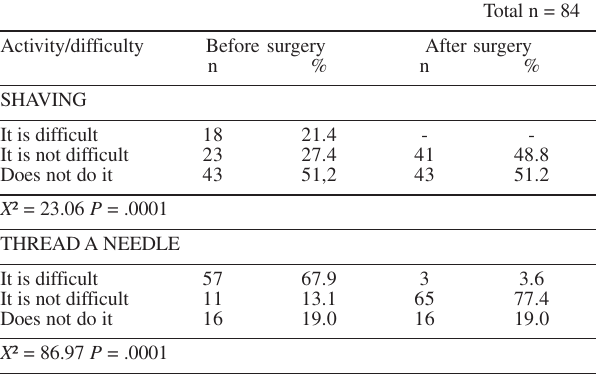
Table 4 - Difficulties in performing routine activities